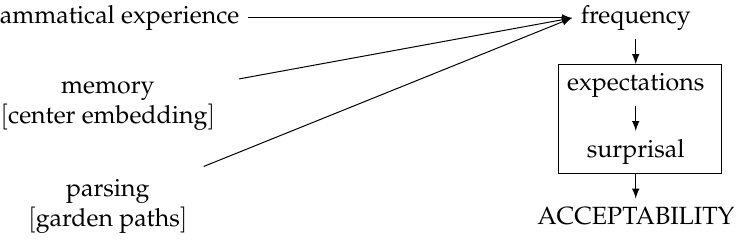
Figure 3. The logic of acceptability judgments for grammatical conditions, version